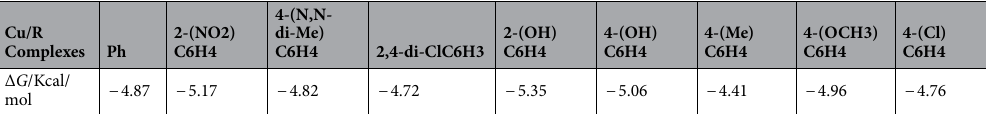
Table 1. Gibbs free energy of Cu and of pyrazoloquinolines derivatives’ structure (R = Ph, 2-(NO2)C6H4, 4-(N,N-di-Me)C6H4, 2,4-di-ClC6H3, 2-(OH)C6H4, 4-(OH)C6H4, 4-(Me)C6H4, 4-(OCH3)C6H4, 4-(Cl) C6H4) and Cu